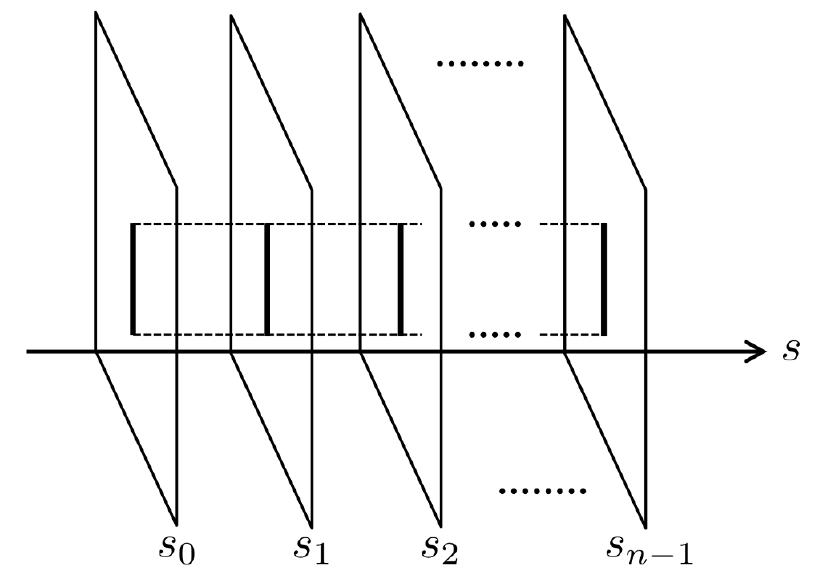
Figure 7 . M5-branes are located at s = s k with k = 0 ; 1 ; (cid:1) (cid:1) (cid:1) ; n (cid:0) 1 labelling the sheets of the Riemann space. The thick line segments represent the branch three-balls and are all identi(cid:12)ed. M2-branes ending on multiple M5-branes correspond to the electrostatic potential distilled from a constant potential by means of contour deformation and there are no charges present in the Riemann space. M2-branes connecting M5-branes all meet at the branch three-balls.